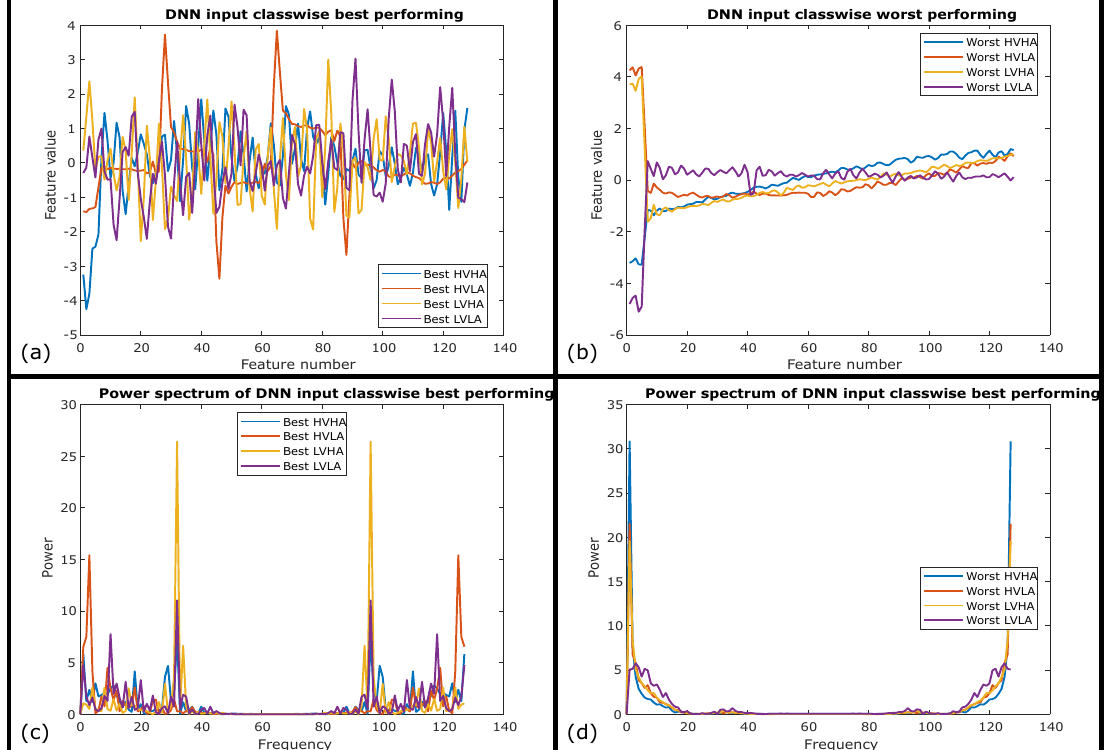
Figure 9. ( a ) Best-performing class-wise GSR samples. ( b ) Worst-performing class-wise GSR samples. ( c ) Spectrum of best-performing class-wise GSR samples. ( d ) Spectrum of worst-performing class-wise GSR